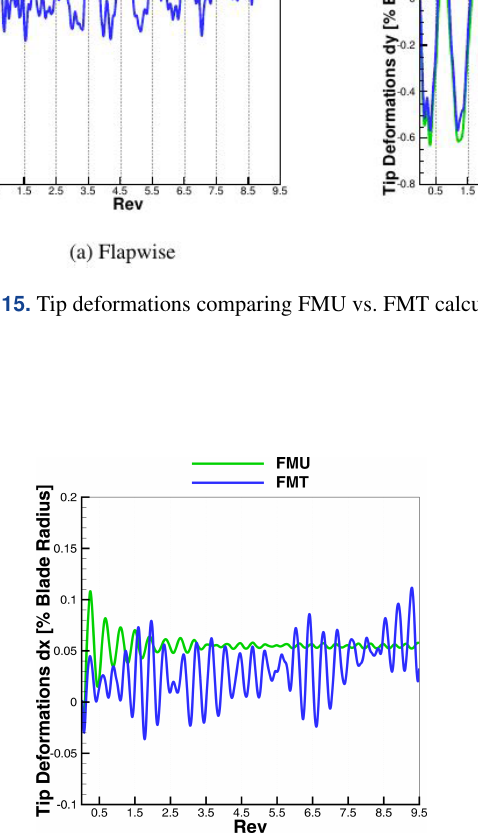
Figure 16. Tower top deformation in flapwise direction calculated with